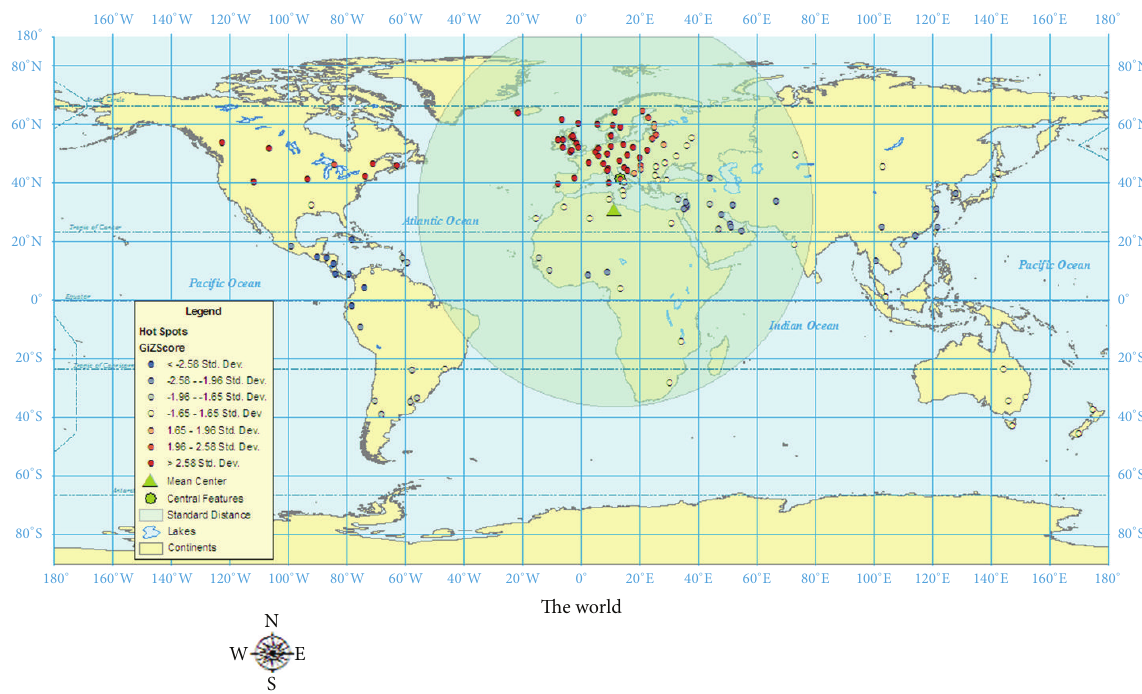
Figure 1: World map of MS prevalence hot spots, Mean Center, Central Feature, and Standard Distance using 131 geocases.